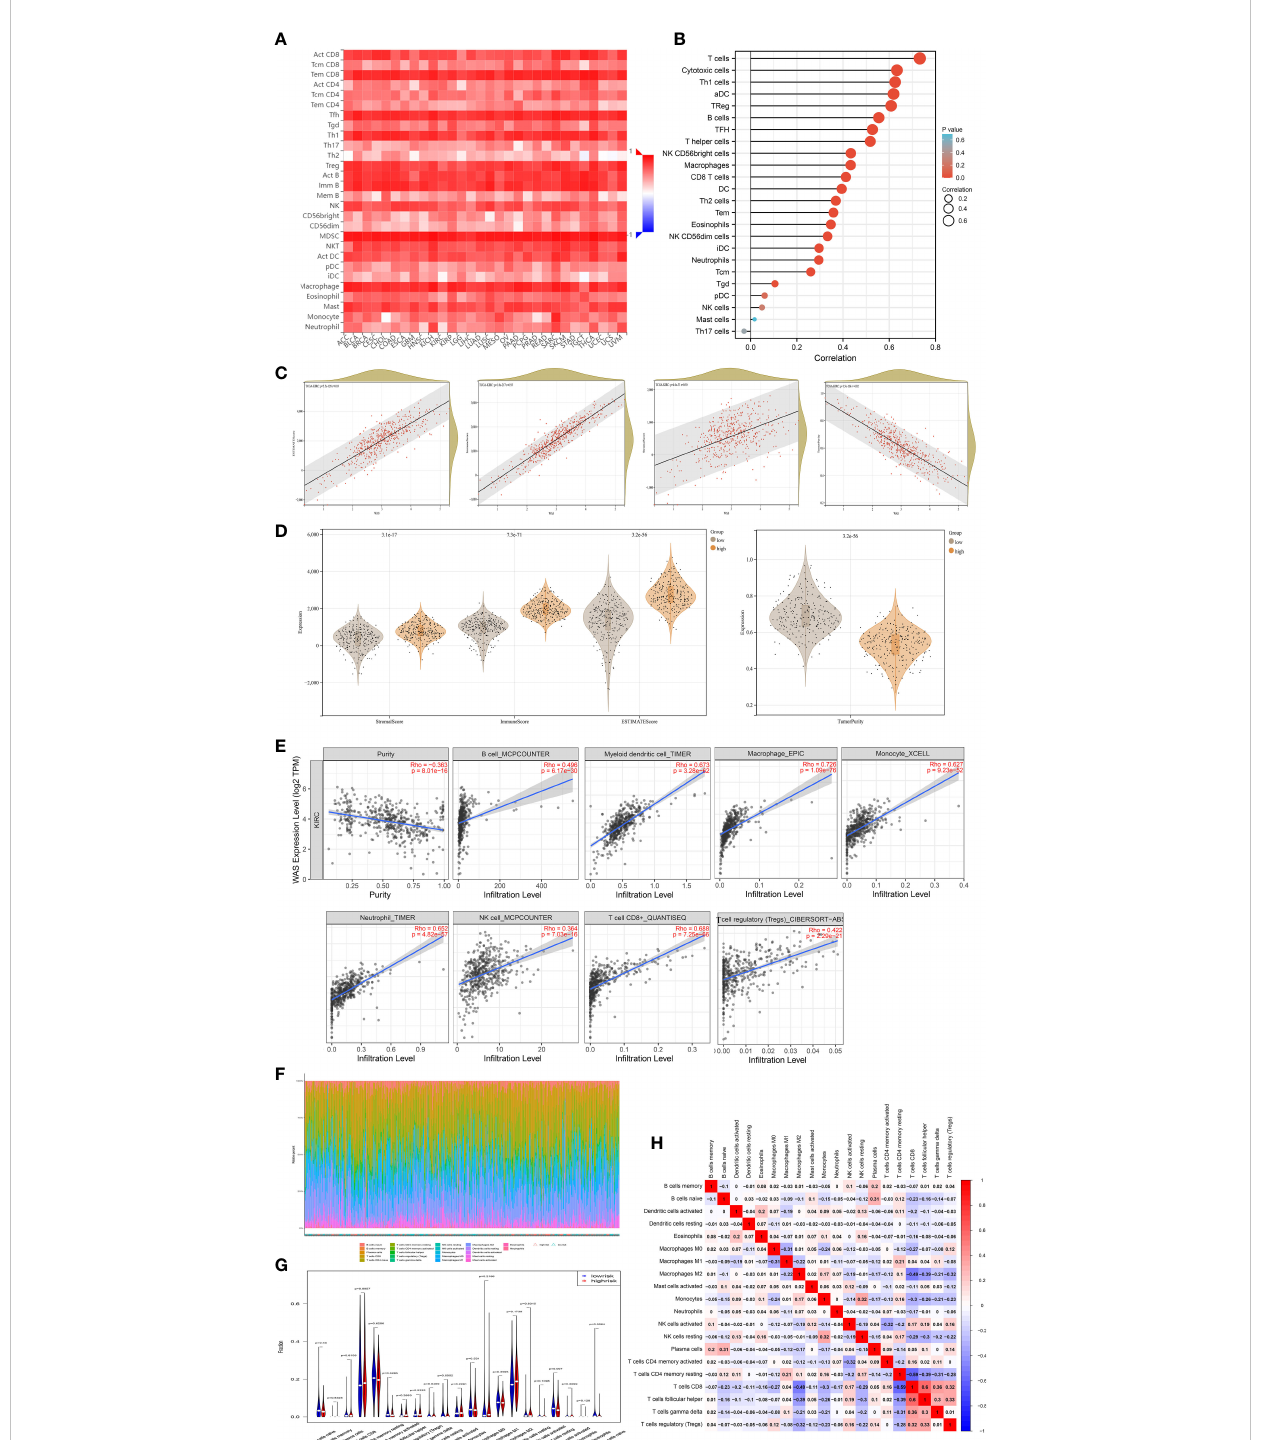
FIGURE 6 Correlation of WAS expression and immune in fi ltration in ccRCC. (A) Correlation between the expression of WAS and the abundance of TILs in ccRCC in the TISIDB database. (B) ssGSEA analysis identi fi ed multiple types of immune cell in fi ltration levels in TCGA ccRCC samples to correlate with WAS. (C) ESTIMATE algorithm showed that WAS expression in ccRCC was positively correlated with stroma and immune scores. (D) Stromal score, immune score, ESTIMATE score and tumor purity was calculated by ESTIMATE algorithm. (E) WAS expression in ccRCC correlated with in fi ltration levels of CD8+ T cells, Treg cells, B cells, neutrophils, macrophages, bone marrow dendritic cells, natural killer cells and monocytes, available in the TIMER2.0 database. (F, G) The speci fi c 22 immune fractions represented by various colors in each sample through CIBERSORT algorithm were shown in barplot and violin. (H) Correlation between 21 types of immune cells. TILs, tumor-in fi ltrating lymphocytes; TIMER2.0, tumor immune estimation resource. Color images are available